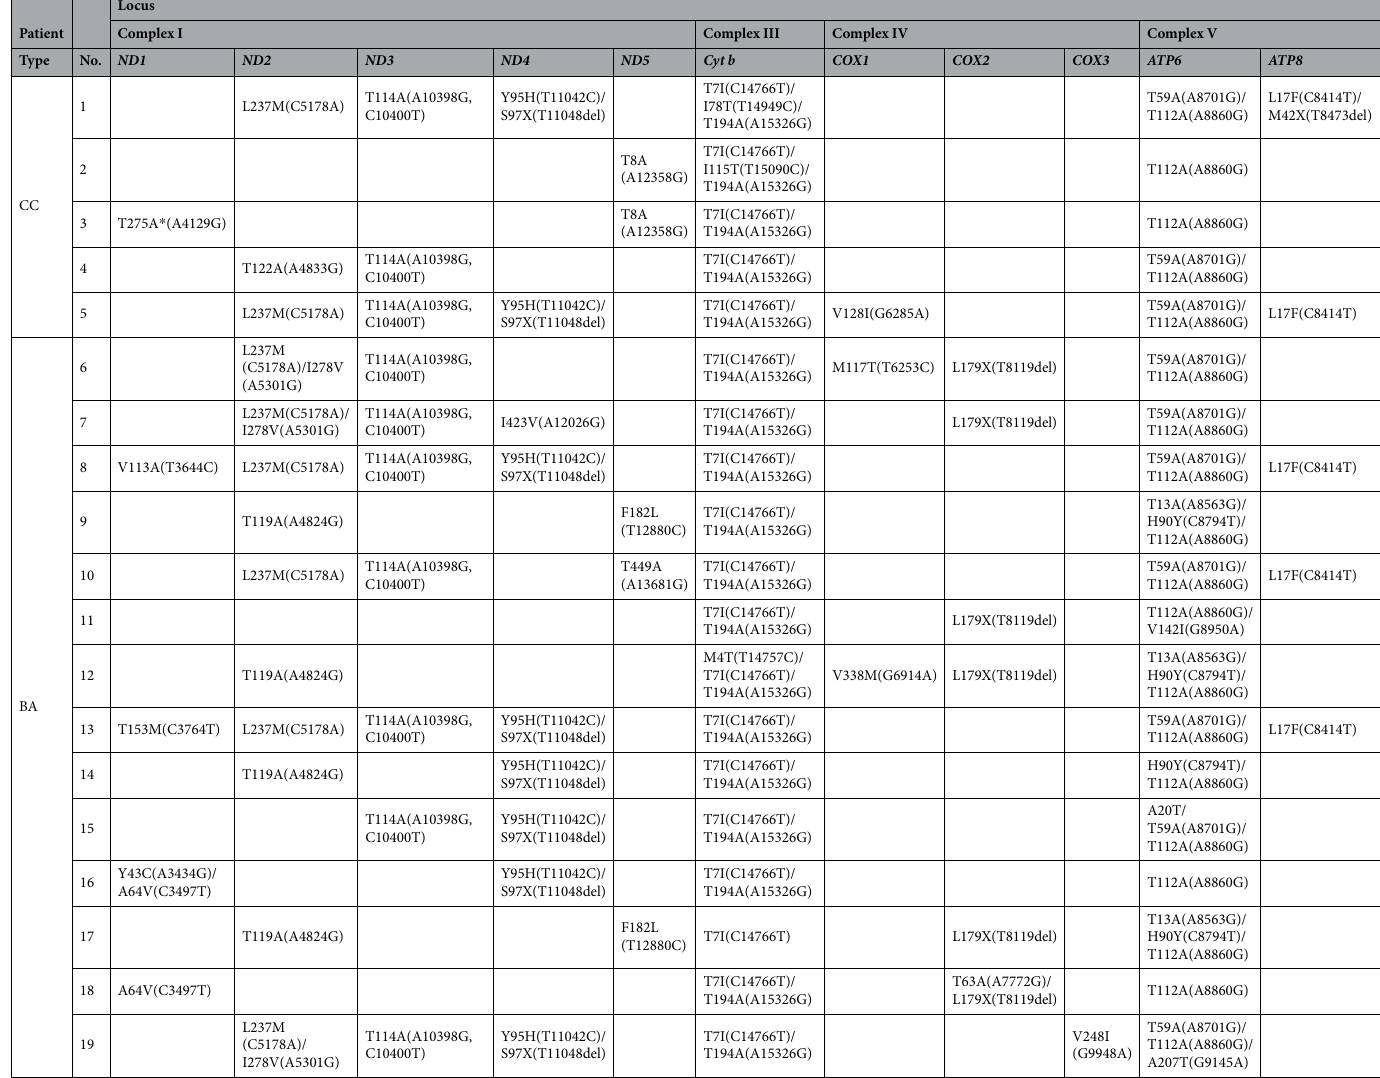
Table 4. Non-synonymous variations in mtDNA encoding regions. * Human residue (Nucleotide) Runs of all 19 patients‘ samples were performed independently in